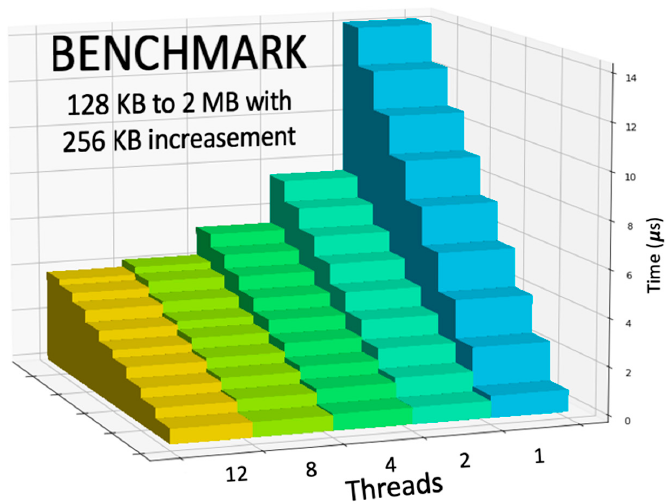
Figure 8. Performance results of a multi-threaded C++ program.